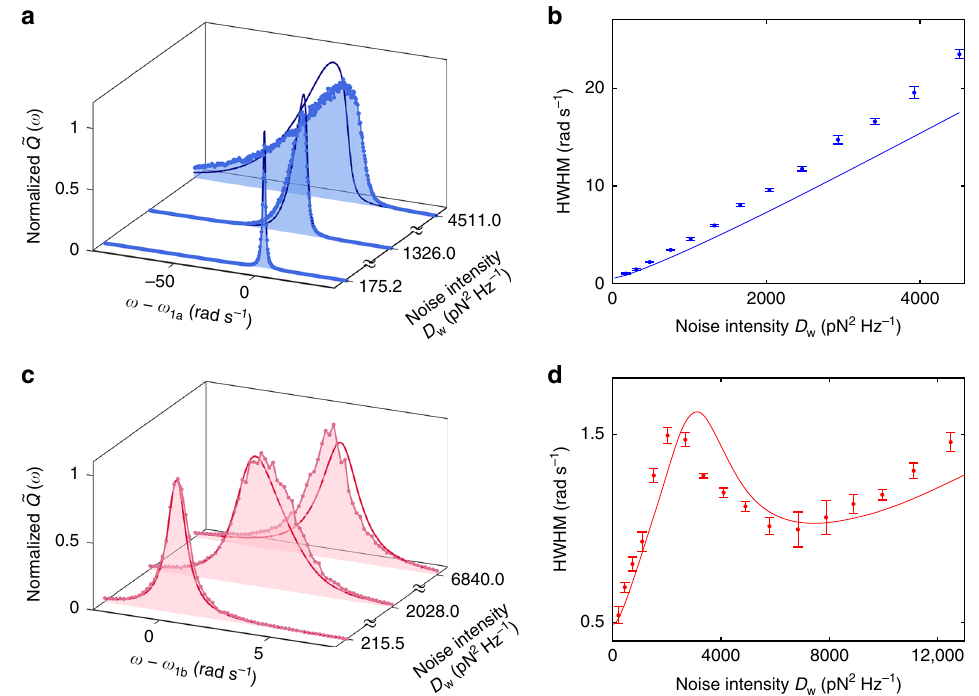
Fig. 3 Spectral widening/narrowing in the conventional/zero-dispersion case. a In the conventional nonlinear regime ( V dc = − 2.3 V), the spectral peak becomes wider and asymmetric as the noise intensity is increased. Each peak is normalized by its maximum measured value. b Measured (circles) and calculated (solid line) half-width at half-maximum (HWHM) of the spectral peaks increase monotonically with the noise intensity. c , d Similar plots for the zero-dispersion regime for V dc = − 1.51 V. Note the difference of scales as compared to a , b , respectively. The HWHM shows a distinctly non-monotonic dependence on the noise intensity, yielding a range of noise intensity where the spectral peak becomes narrower as the noise intensity increases. Error bars represent ±1